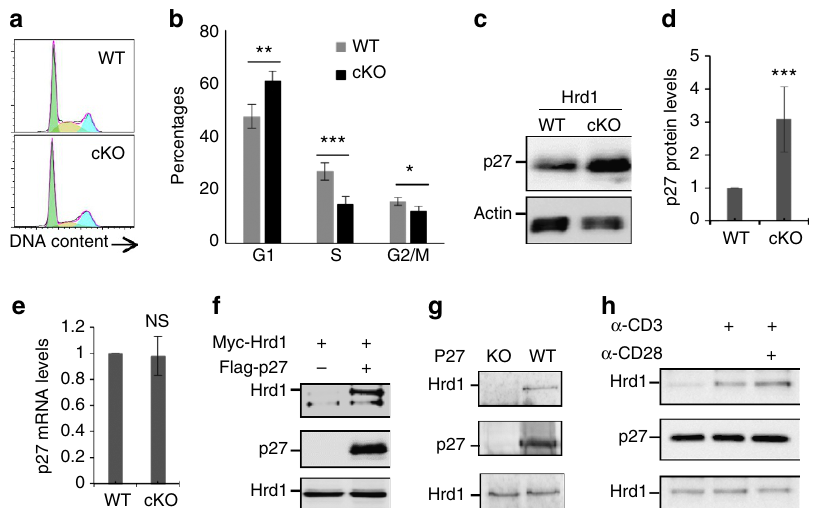
Figure 3 | Hrd1 interacts with p27 kip1 in T cells. WT and Hrd1 cKO CD4 T cells were stimulated with anti-CD3 plus anti-CD28 (2 m gml (cid:2) 1 ) for 24h. ( a , b ) Cell cycle was analysed by DNA staining and flow cytometry. Representative images ( a ) and data from five independent experiments ( b ) are shown. ( c – e ) p27 kip1 protein ( c , d ) and mRNA ( e ) levels were analysed by immunoblotting and real-time PCR with reverse transcription. Representative images ( c ) and data from five independent experiments ( d ) are shown. ( f ) HEK293 cells were transfected with Myc-tagged Hrd1 and Flag-p27. The interaction of Hrd1 with p27 kip1 in the transiently transfected cells was determined by co-immunoprecipitation with anti-Flag and the bound Hrd1 was detected by immunoblotting with anti-Myc antibody (top panel). The same membrane was re-blotted with anti-Flag antibody (middle panel) and the expression levels of Hrd1 in the whole-cell lysates were confirmed by immunoblotting (bottom panel). ( g ) CD4 Tcells from WTand p27 kip1 KO mice were stimulated with anti-CD3 plus anti-CD28 for 24h. The interaction of p27 kip1 with Hrd1 was analysed by immunoprecipitation with anti-p27 and immunoblotting with anti-Hrd1 antibody (top panel). The expression levels of p27 (middle panel) and Hrd1 (bottom panel) in whole-cell lysate was confirmed by immunoblotting. ( h ) CD4 Tcells were stimulated with anti-CD3 or anti-CD3 plus anti-CD28 for 30min, and Hrd1 interaction with p27 kip1 was determined as in g . Error bars ( b , d , e ) represent data from five pairs of mice (mean þ s.d.). Mann–Whitney test was used for the statistical analysis. NS, no significant difference; * P o 0.05, ** P o 0.01 and *** P o